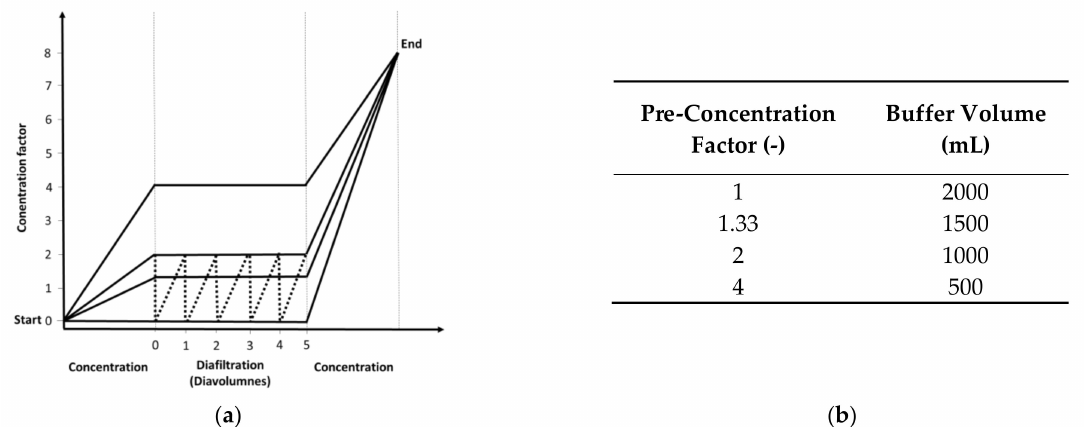
Figure 2. Experimental procedure for the five UF/DF processes. ( a ) Variation of the tested process and ( b ) buffer consumption for the diafiltration processes with respect to the pre-concentration factors. Solid line = continuous diafiltration. Dotted line = discontinuous diafiltration